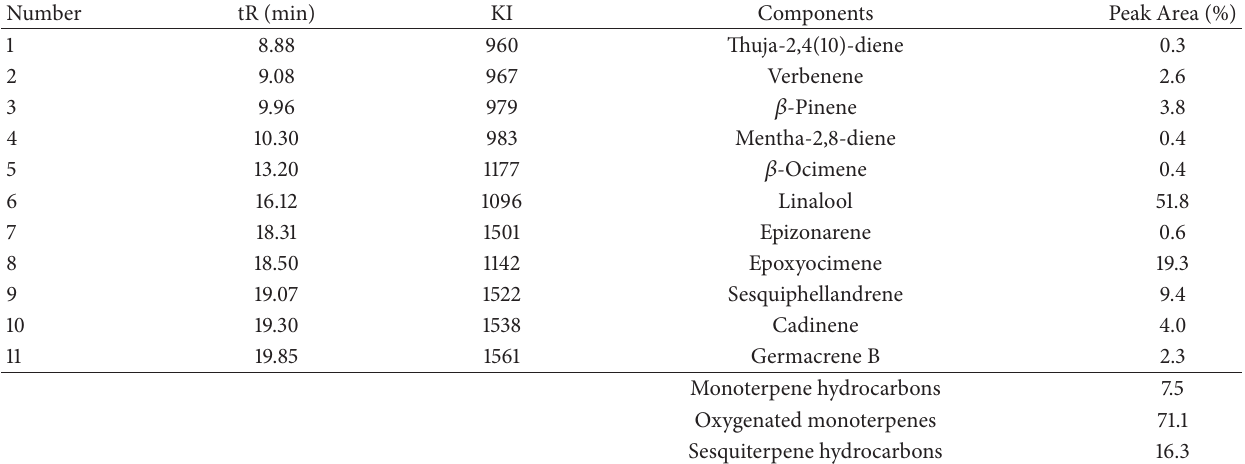
Table 1: Major constituents of the essential oils of M. piperita .